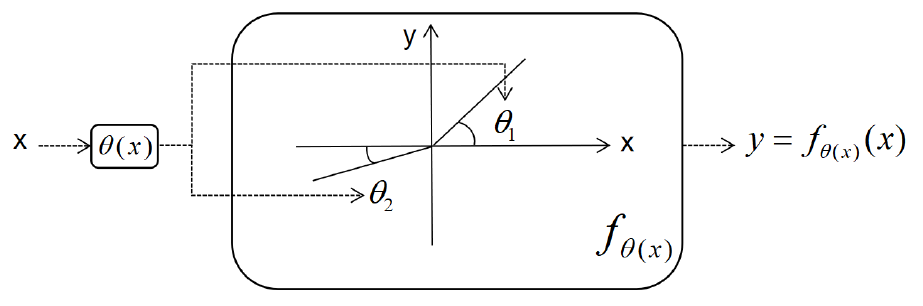
Figure 3. Scheme of dynamic ReLU